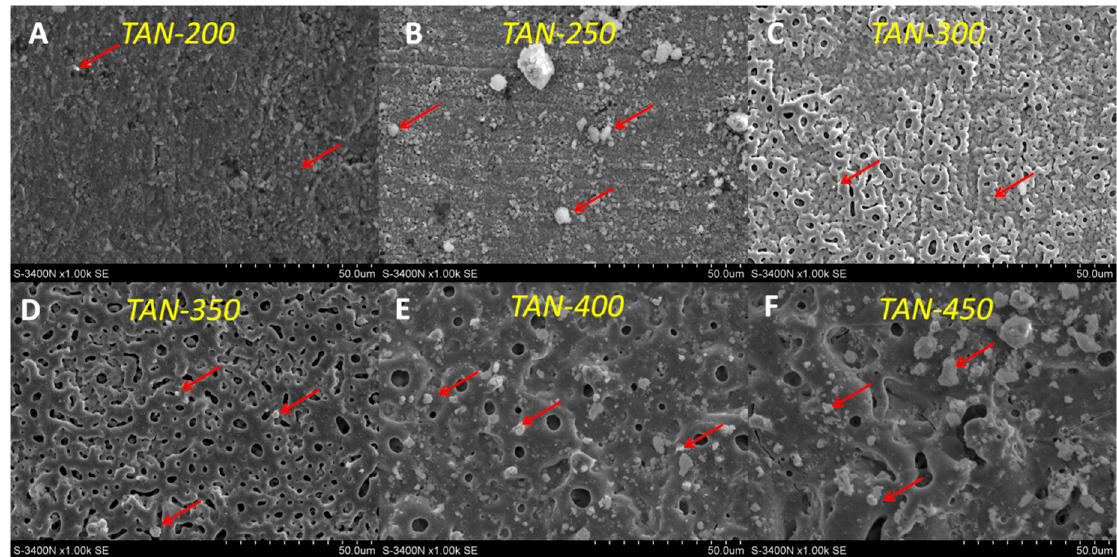
Figure 2. SEM images of the coatings formed on the Ti-6Al-7Nb surface in the solution composed of 150 g/dm 3 hydroxyapatite particles at: ( A ) 200 V, ( B ) 250 V, ( C ) 300 V, ( D ) 350 V, ( E ) 400 V and ( F ) 450 V. Particles of hydroxyapatite are marked by red arrows.